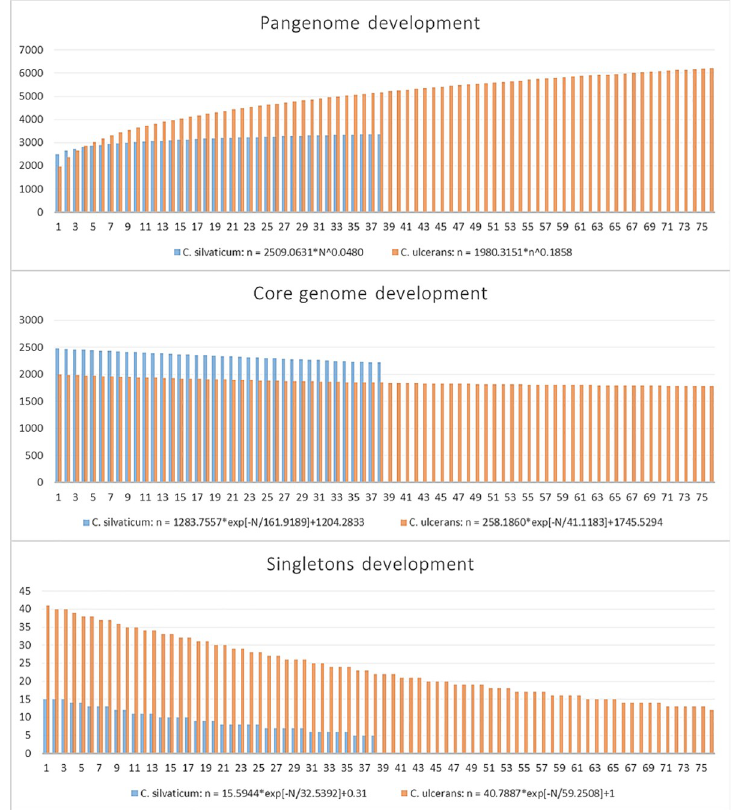
Fig 6. Pangenome, core genome and singletons development graphs and formulas for 38 genomes of Corynebacterium silvaticum and 76 C . ulcerans